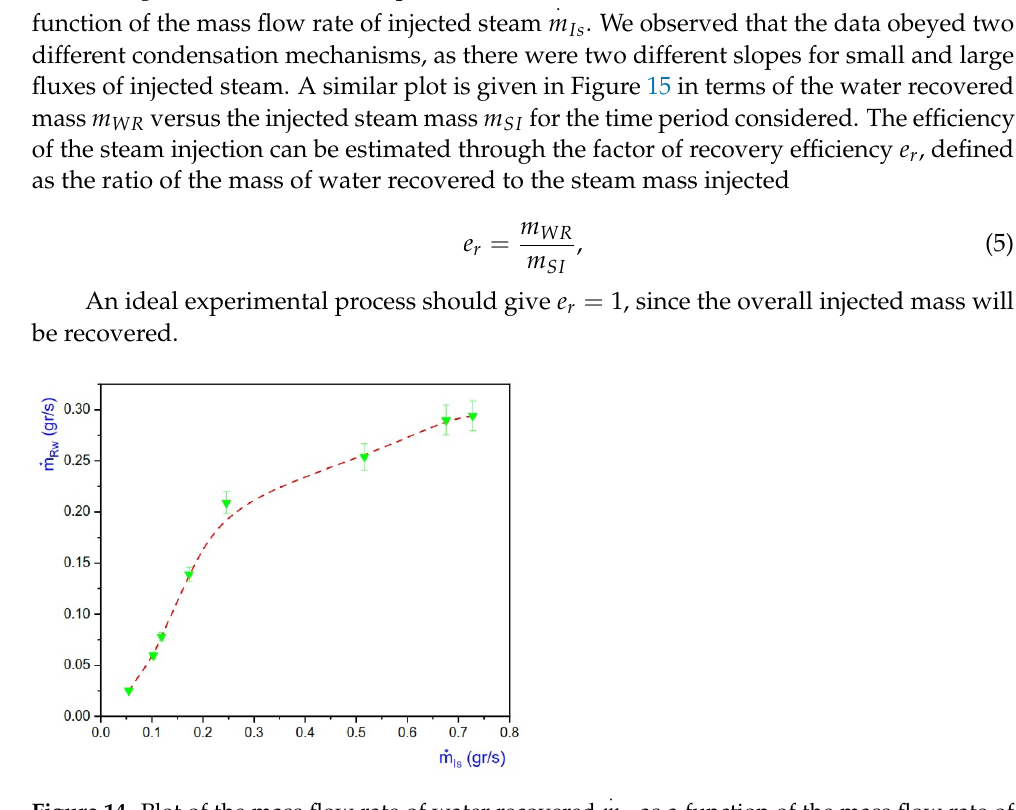
Figure 14. Plot of the mass flow rate of water recovered · m Is steam injected